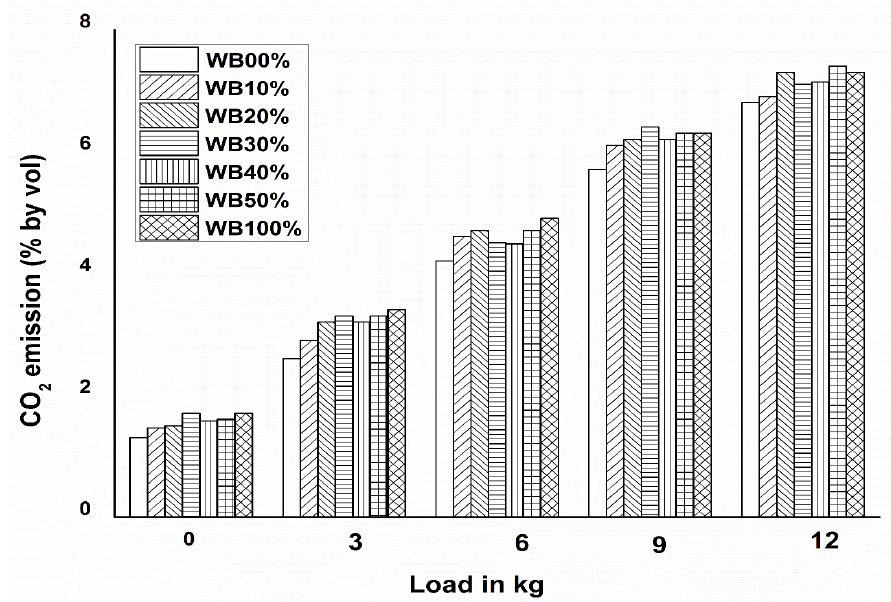
Figure 8. CO 2 emissions’ variation against load for biodiesel and the blends (kg). CO 2 emissions become insignificant for the atmosphere, as plants consume it via pho- tosynthesis [33]. Theoretical studies also validate the rise in CO 2 emissions from diesel